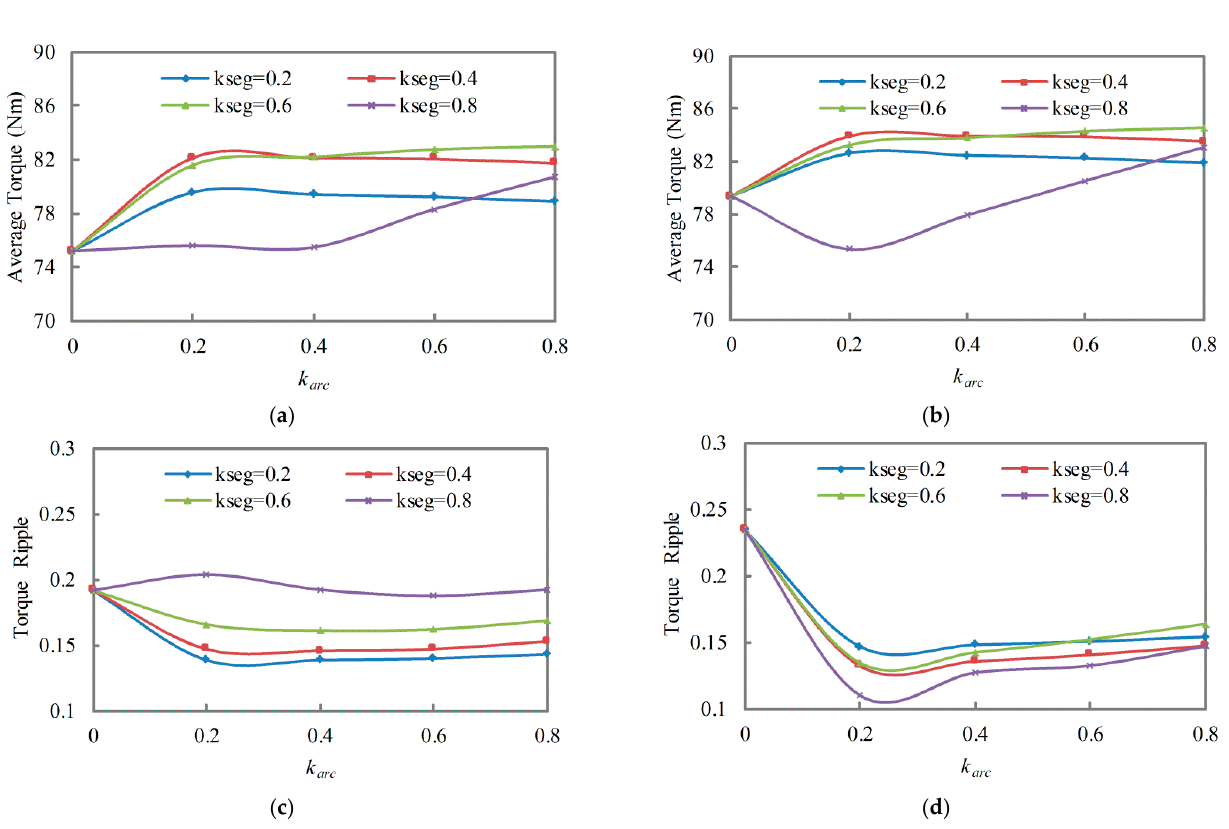
Figure 11. The effect of k seg and k arc on average torque and torque ripple of motor with different number of flux barrier layers ( a ) average torque of three-layer flux-barriers; ( b ) average torque of four-layer flux-barriers; ( c ) torque ripple of three-layer flux barriers; ( d ) torque ripple of four-layer flux-barriers.